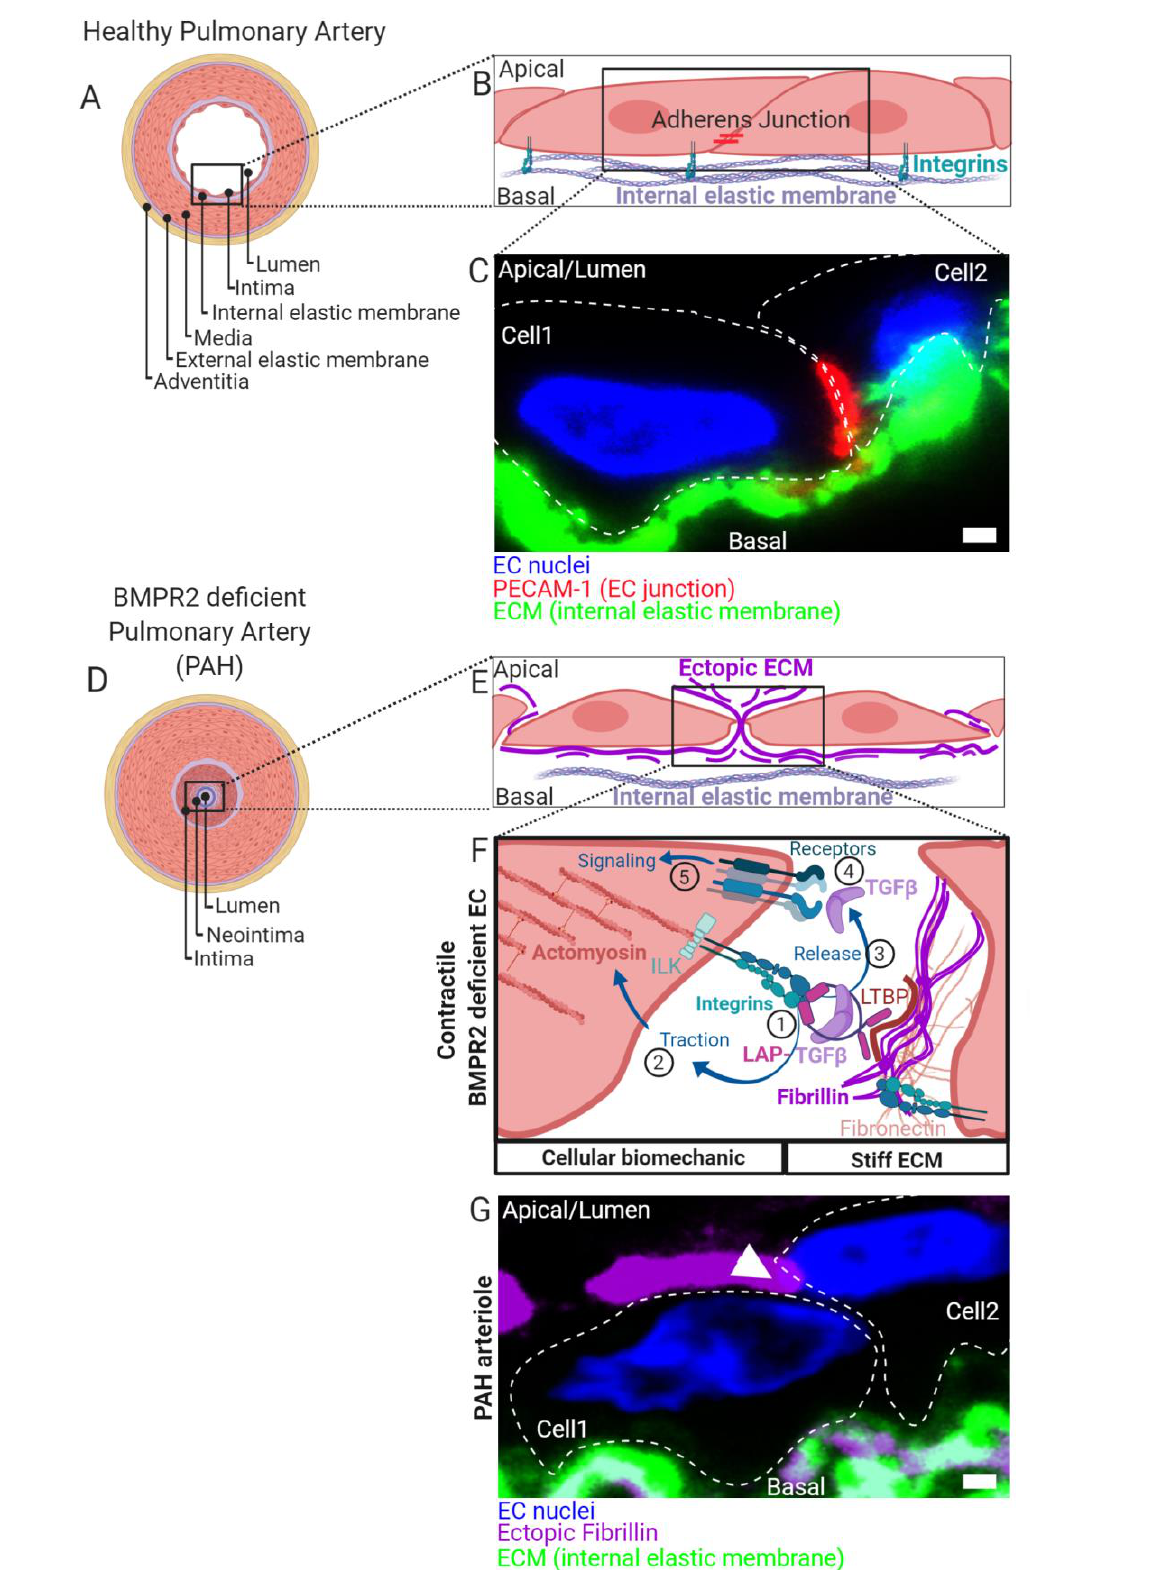
Figure 1: (A) Healthy pulmonary artery is characterized by a discrete macroscopic organization of tissue and extracellular matrix (ECM) layers (blue) from the inside to the outside of a blood vessel. Facing the lumen, the intima is formed by a thin layer of endothelial cells followed by a discrete ECM layer composing the internal elastic membrane. A big contribution to wall stability is made by the media formed by